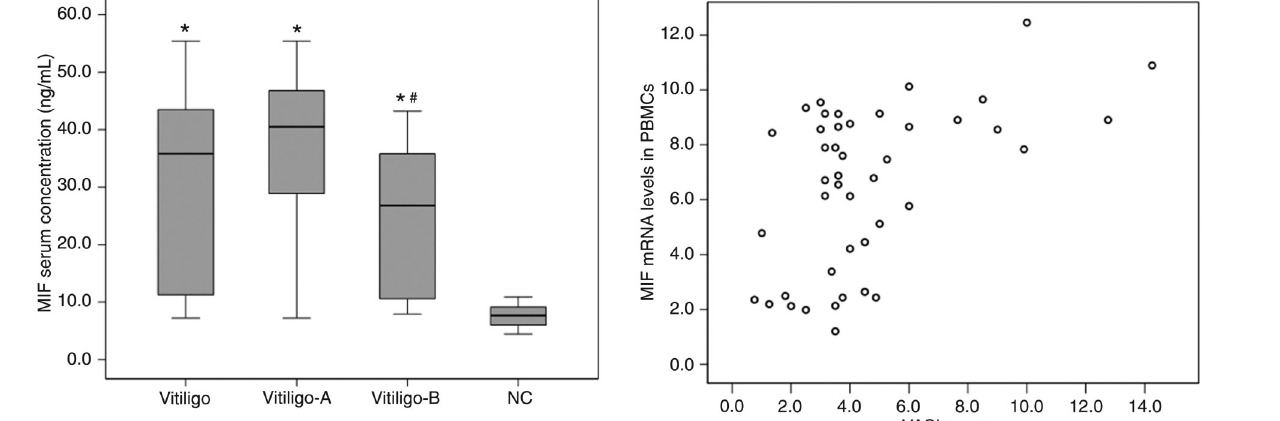
Figure 4. Correlation of migration inhibitory factor (MIF) mRNA levels in peripheral blood mononuclear cells (PBMCs) with vitiligo area severity index (VASI) scores of vitiligo vulgaris patients (r = 0.426, P = 0.004, Spearman’s correlation